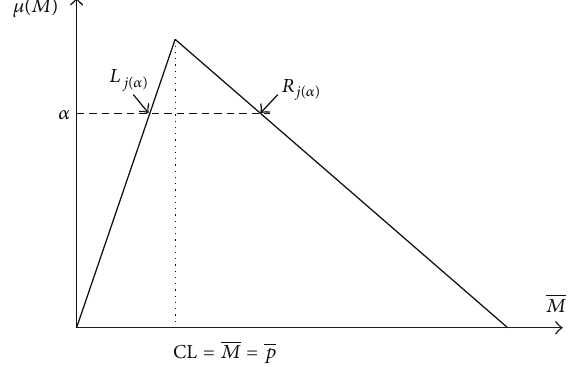
Figure 5: TFN for 𝑀 and 𝑀 𝑗 for sample 𝑗